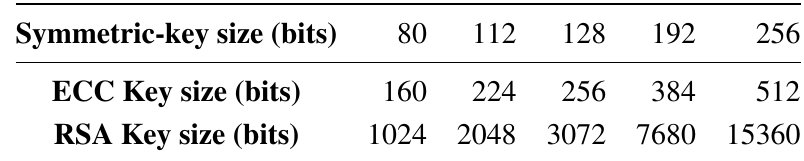
Table 2. Comparison of security levels between symmetric ciphers, ECC, and RSA (Recommended NIST key